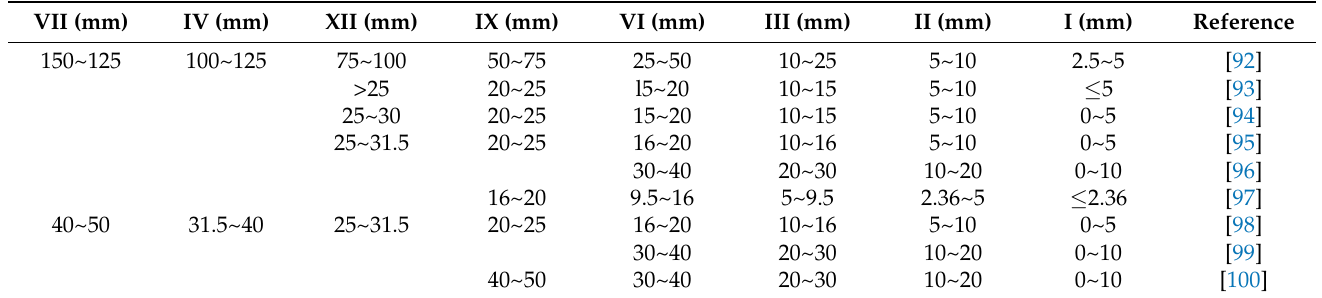
Table 2. Grain size grading of gangue in gangue